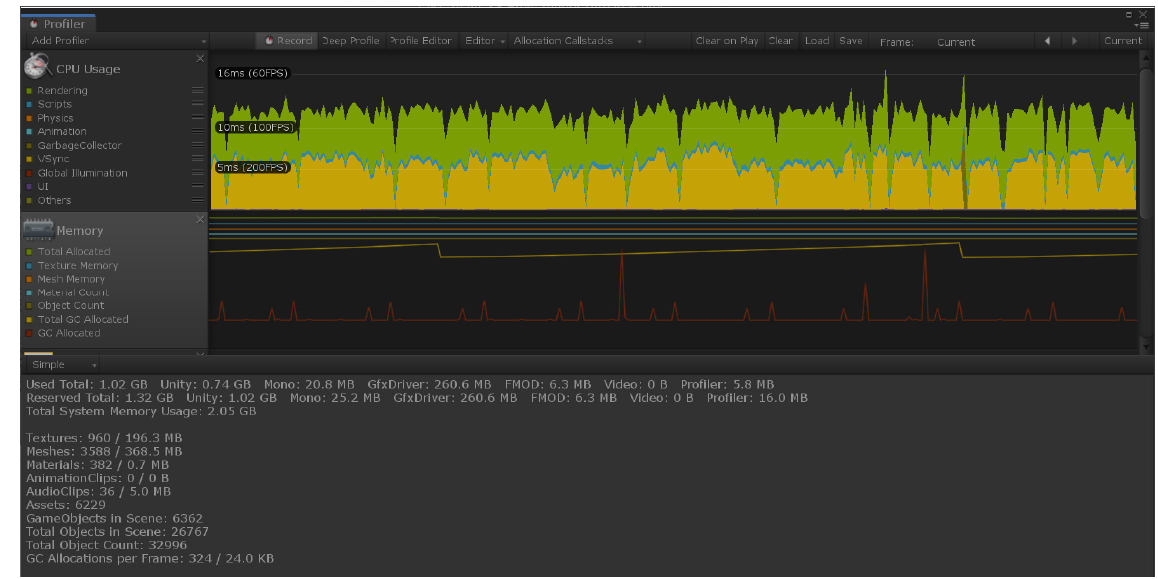
Figure 14. Unity3d Profiler Tool.